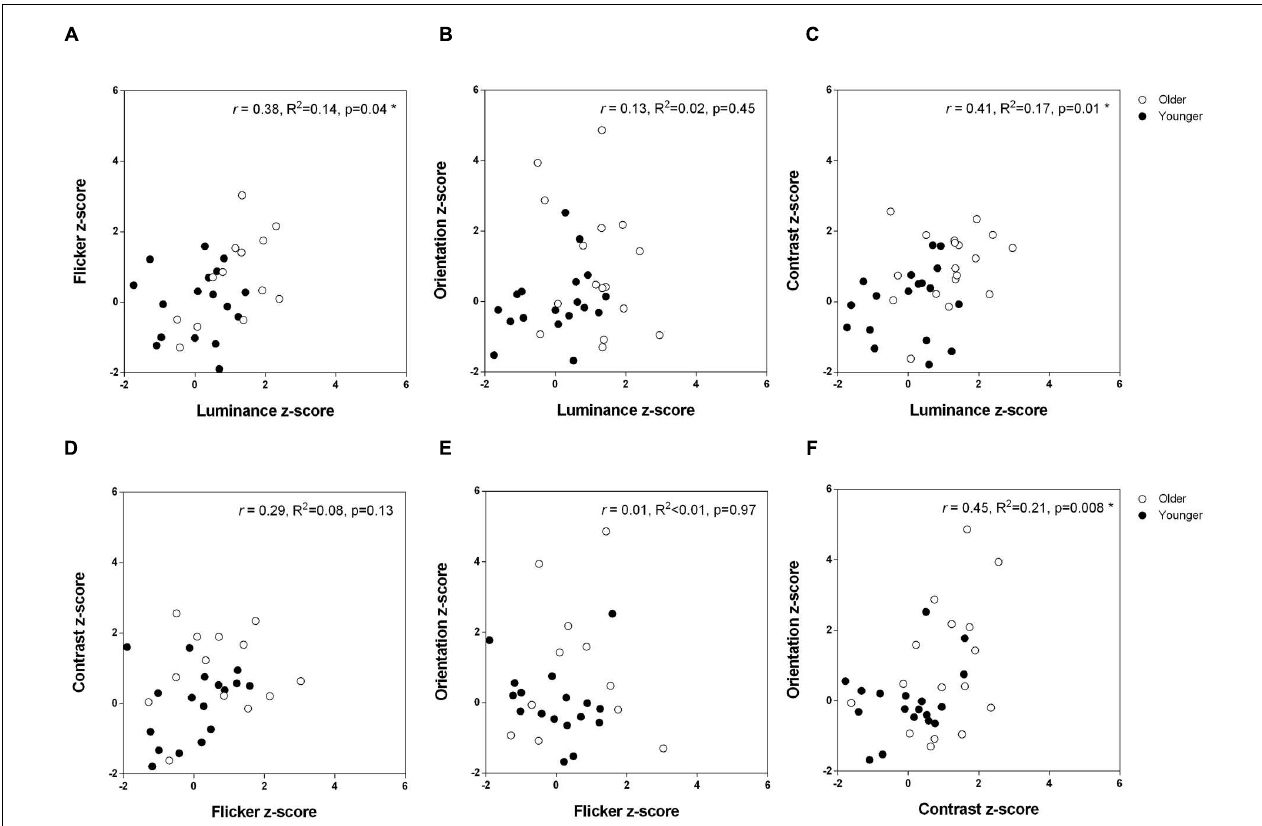
FIGURE 5 | The relationship between strength of surround suppression across the different tasks. Pearson correlation coefficients are shown for the two groups combined. (A) Flicker versus luminance (B) Orientation versus luminance (C) Contrast versus luminance (D) Contrast versus flicker (E) Orientation versus flicker (F) Orientation versus contrast.